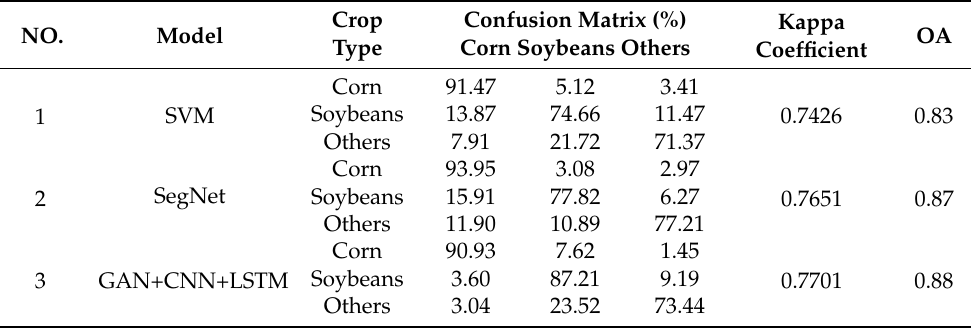
Table 4. Quantitative evaluation of the model’s prediction results in Pickaway County.